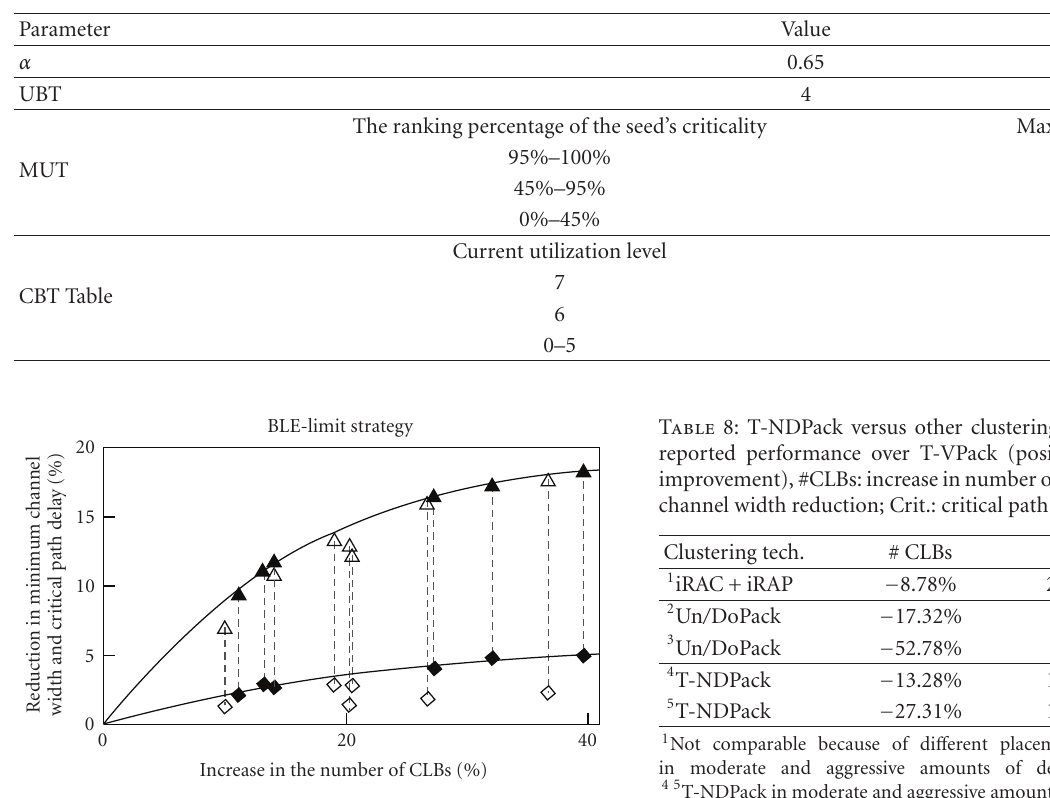
Table 6: α , UBT, MUT, CBT: best configuration for performance analysis of T-NDPack.